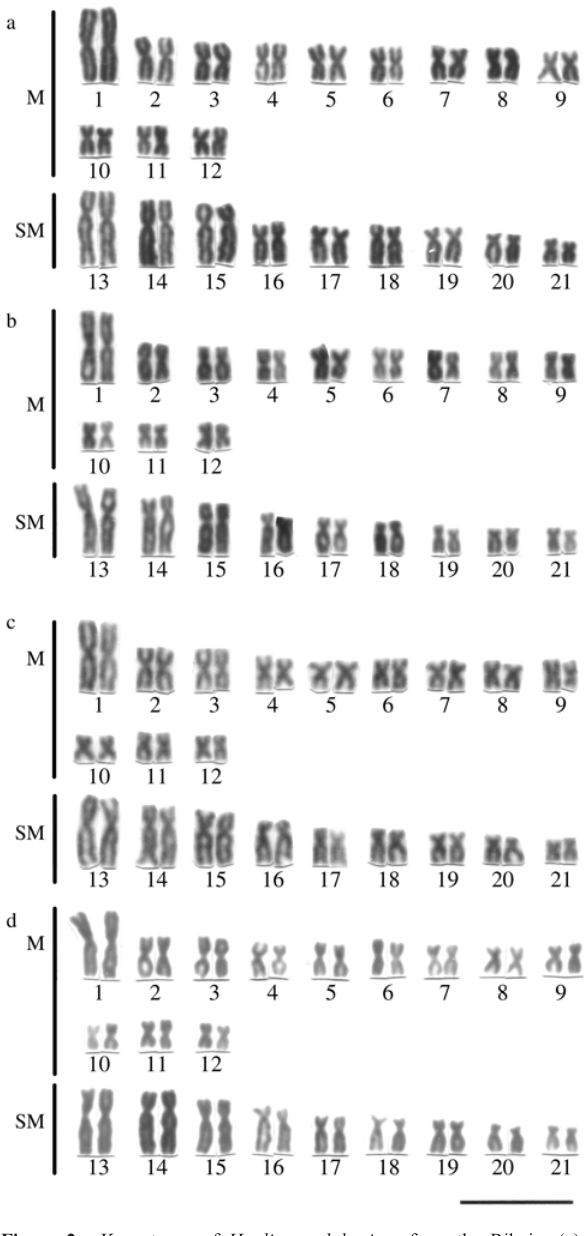
Figure 2 - Karyotypes of Hoplias malabaricus from the Ribeira (a), Tibagi (b), Ivaí (c), and Iguaçu (d) populations (conventional Giemsa staining). Bar equals 5 µ m.